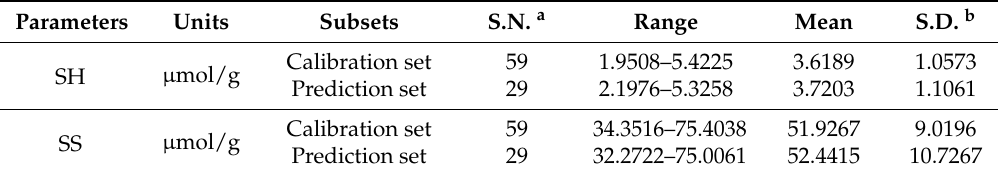
Table 2. Reference values for each process parameter in the calibration and prediction set. Parameters